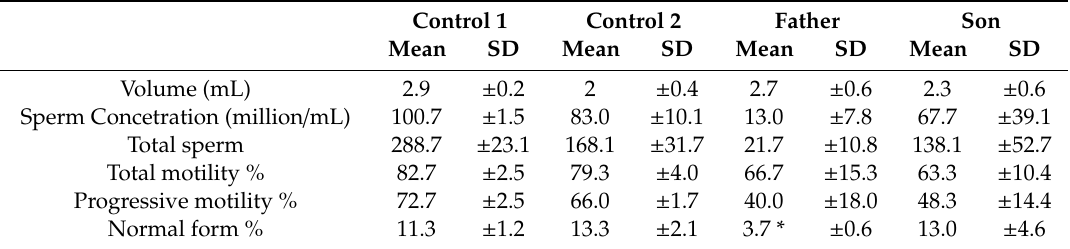
Table 1. Semen parameters in controls, father and